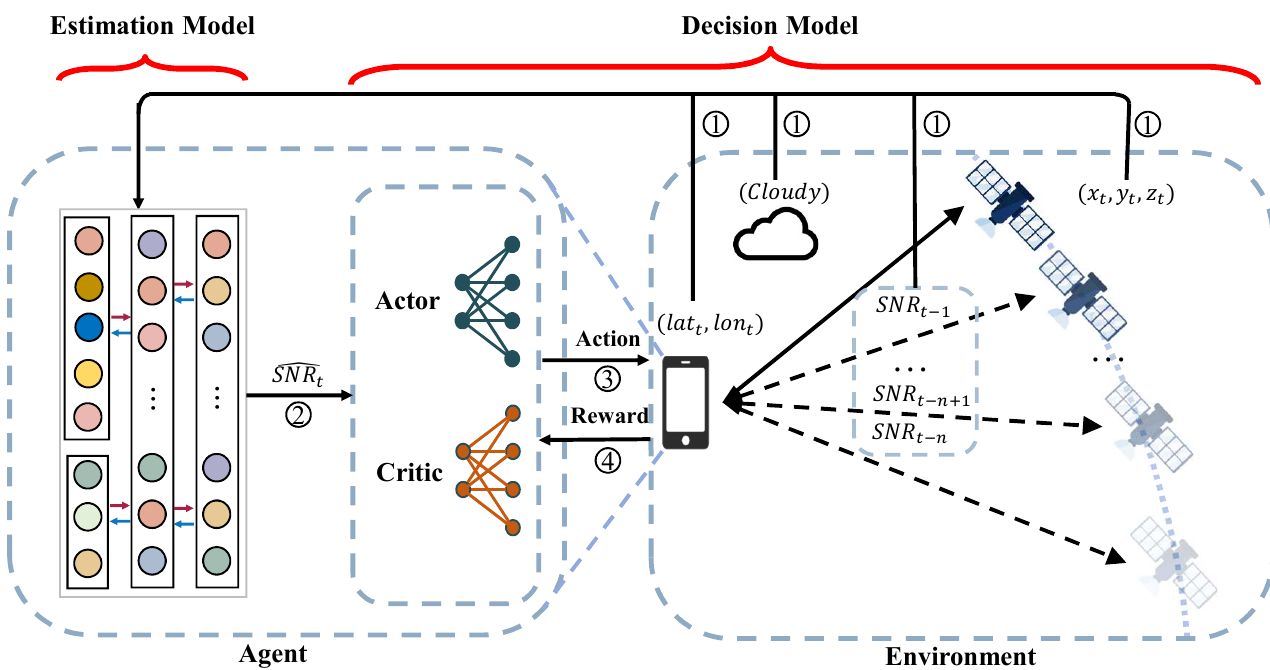
Figure 3. Proposed intelligent weather-conscious AMC for global satellite-to-ground